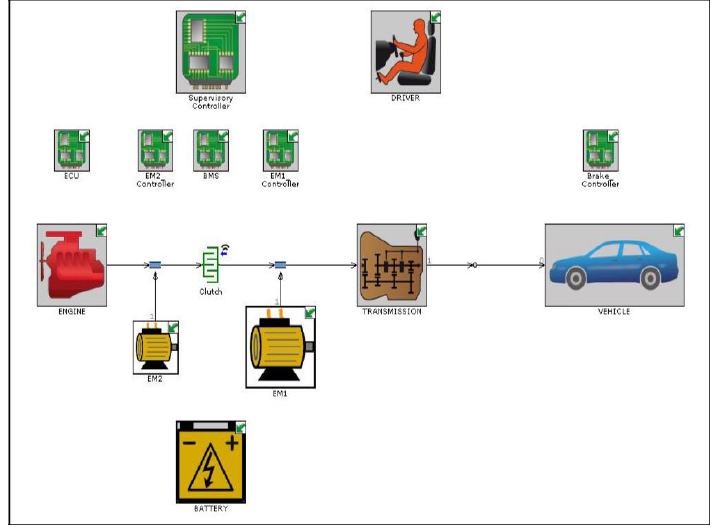
Figure 7. Series-parallel hybrid electric vehicle (HEV) model.